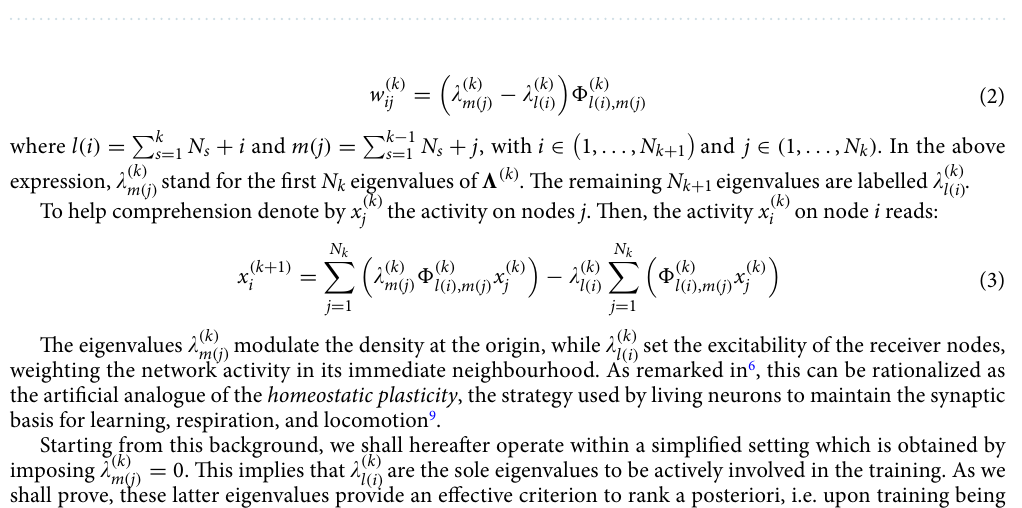
Figure 2. The structure of matrix (cid:31) (